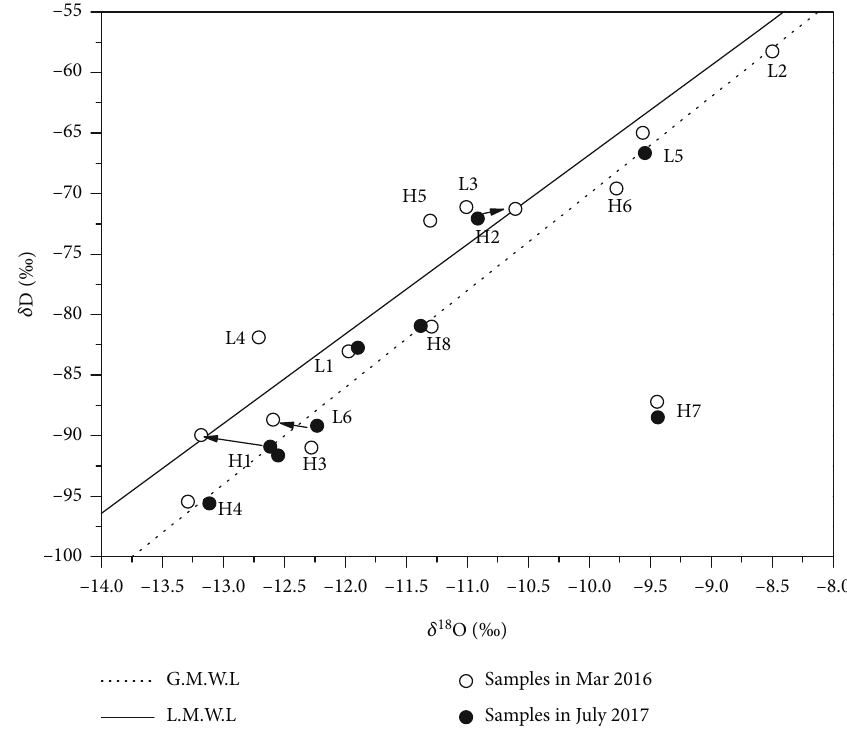
Figure 6: Plot of δ 18 O and δ D in groundwater from the HFZ and LFZ fault zones for samples collected in the dry and rainy seasons. GMWL, Global Meteoric Water Line [40]; LMWL, Northwestern China Local Meteoric Water